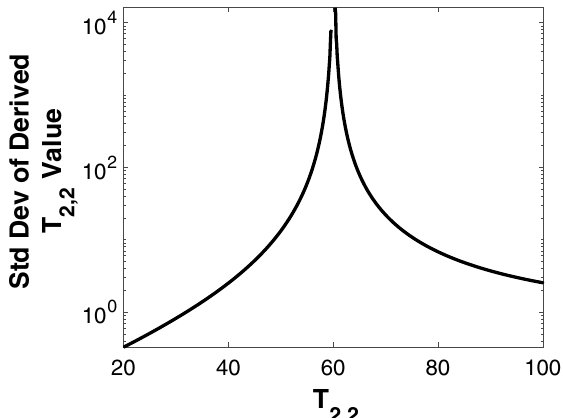
Figure 2. Analytical calculation of the standard deviations for T 2,2 recovery from the biexponential 1D model, 60 ms throughout. Values are obtained from the square root of the diagonal as a function of T 2,2 . T 2,1 = elements of the covariance matrix defined by Eq.